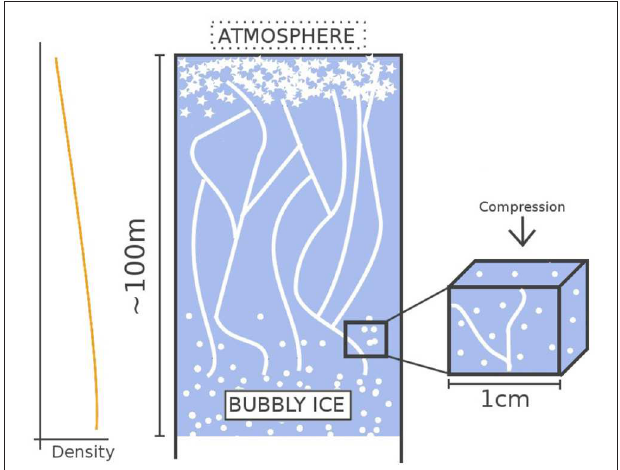
FIGURE 1 | Scheme of a firn column with a decreasing porosity with depth (white inclusions in the firn) until it transforms into airtight ice. The scheme shows the transformation of the open porosity (long connected white channels) into closed bubbles. This paper focuses in modeling small scale firn samples originating from the bubble closure zone in deep firn, similarly to the zoomed box on the right